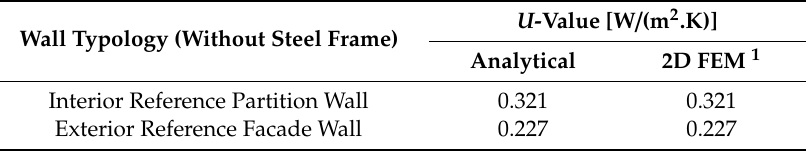
Table 6. Thermal transmittances obtained for simplified wall models with homogeneous layers.